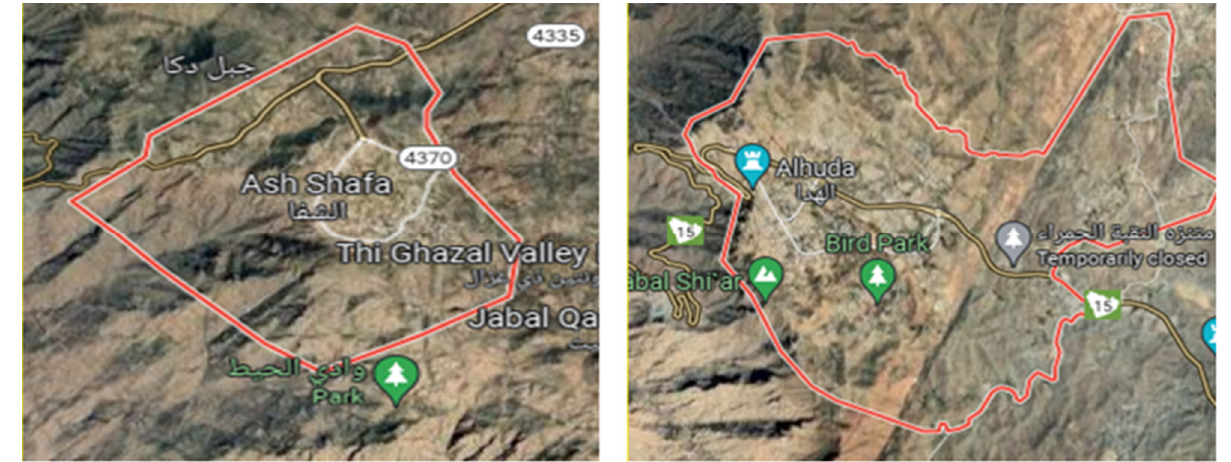
Figure 1. Map of the studied area (Alshafa and Alhada), (Adopted from https://www.google.com/ maps/place/Alhuda/@21.3576171,40.2116973,30169m/data=!3m1!1e3!4m5!3m4!1s0x15e9f53ca39b5a3 5:0xbdbc9ddc70a2f409!8m2!3d21.3648223!4d40.2803491 (accessed on 10 March 2022).